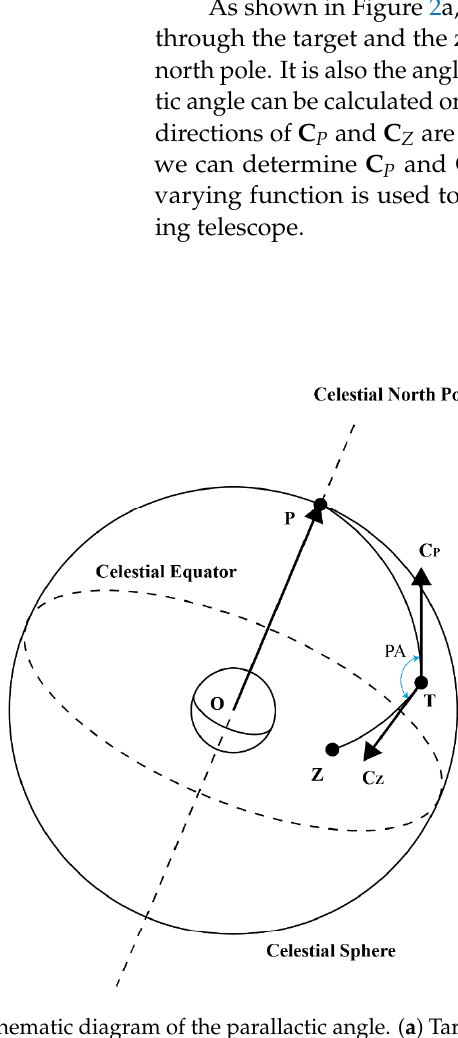
Figure 2. Schematic diagram of the parallactic angle. ( a ) Target and several reference points on a celestial sphere. ( b ) Vectors corresponding to ( a ). O is the Earth’s center . O ’ is the location of the observer. P is a unit vector from O pointing to the north celestial pole. P ’ is a unit vector from O’ pointing to the north celestial pole. C P and C Z are the tangent vectors of the great circle through P and T at T and through Z and T at T , respectively. The remaining points and vectors correspond to those with the same names introduced in Figure 1.